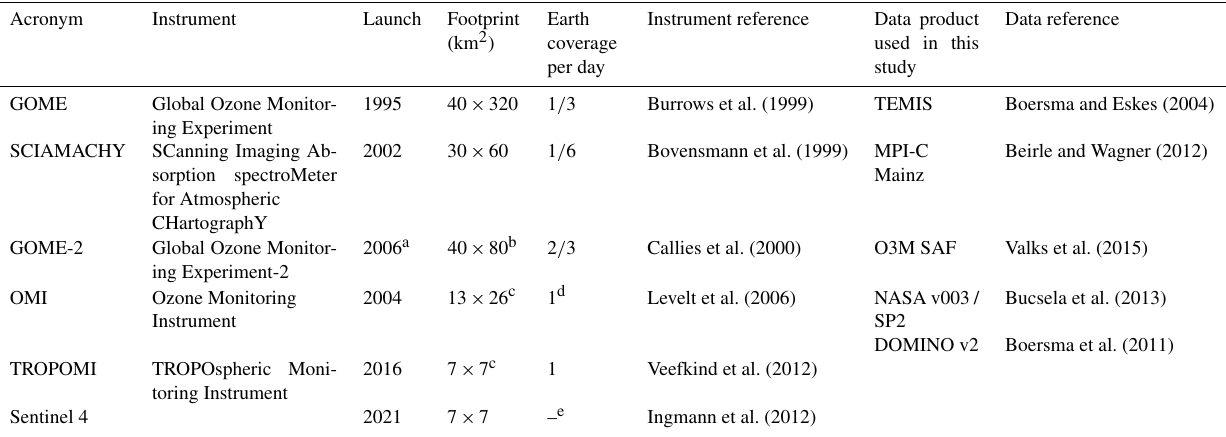
Table 1. UV/vis satellite instruments compared or discussed in this